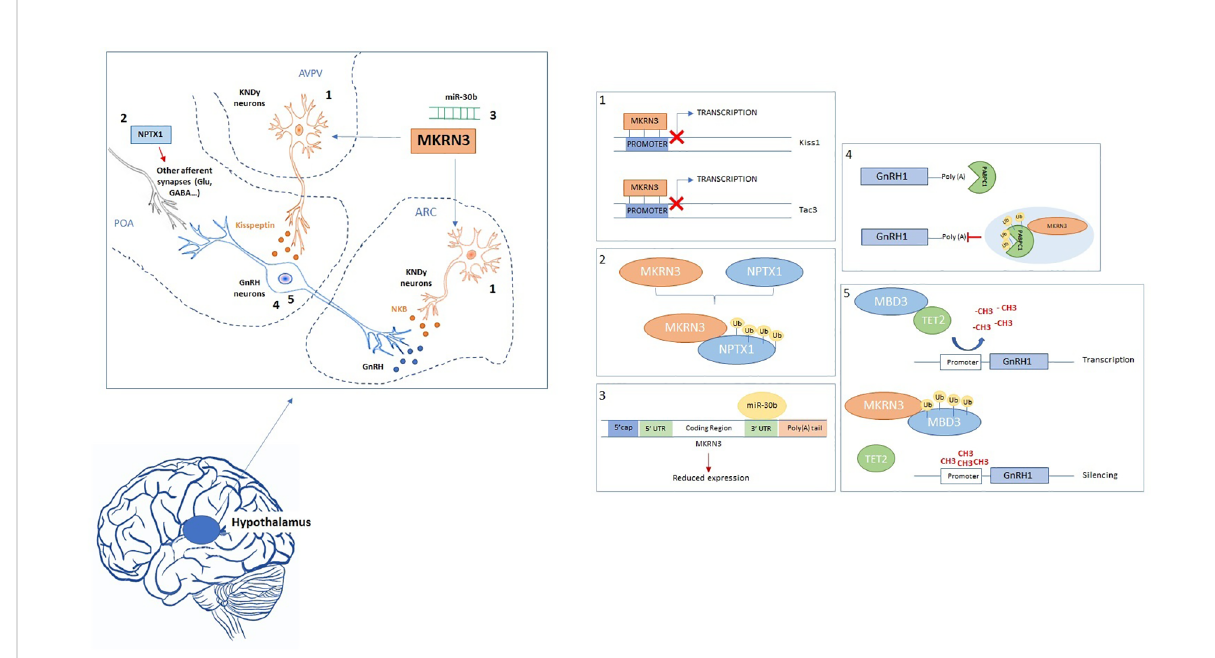
FIGURE 2 Schematic picture of MKRN3 interactions. The fi gure summarizes the neuronal mechanisms of action of MKRN3 and its effectors. The insert on the left shows the hypothalamus and the different nuclei that are encircled by dotted blue lines. The GnRH neuron is depicted in blue while KNDy (Kisspeptin-Neurokinin-Dynorphin) neurons are shown in orange. In the inserts on the right are represented the mechanisms of action of MKRN3 on its targets. The number of each insert report the position of the interaction on the hypothalamic neurons. Red X indicates inhibitory action. POA, preoptic area; AVPV, anteroventral periventricular nucleus; ARC, arcuate